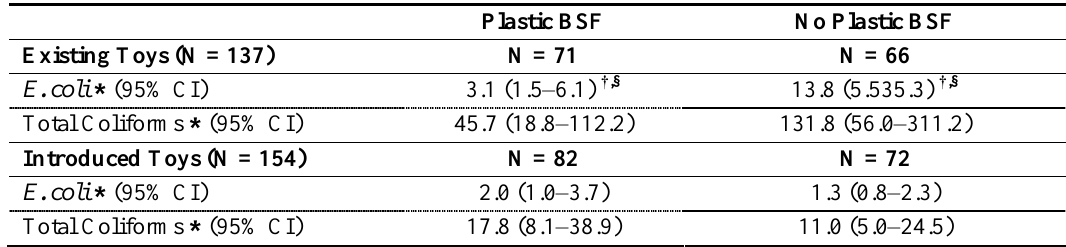
Table 4. Comparison of geometric mean concentrations and 95% confidence intervals of E. coli and Total Coliforms on both existing toys and toys introduced for two weeks for households with and without the plastic BSF participating in a RCT of the plastic biosand filter in Copan, Honduras